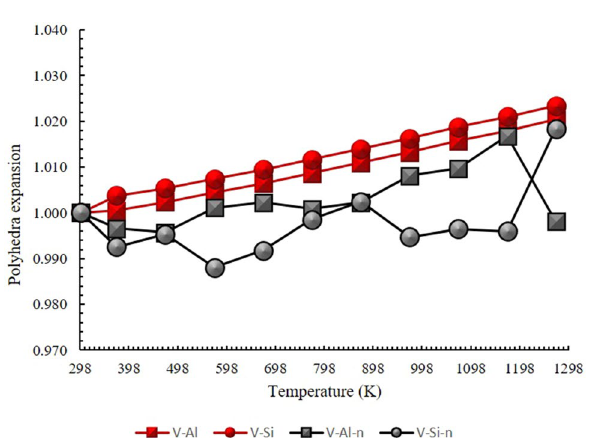
Figure 6. Thermal expansion model for in situ heating of the PadPar topaz, obtained from synchrotron ( a ) and neutron diffraction ( b ) analyses in the temperature range of 298 to 1273 K. Orange, yellow, green and blue symbols refer to Temperature vs Volume data selected for the EoS fitting (see text for details). Standard deviation errors are within the symbol size.